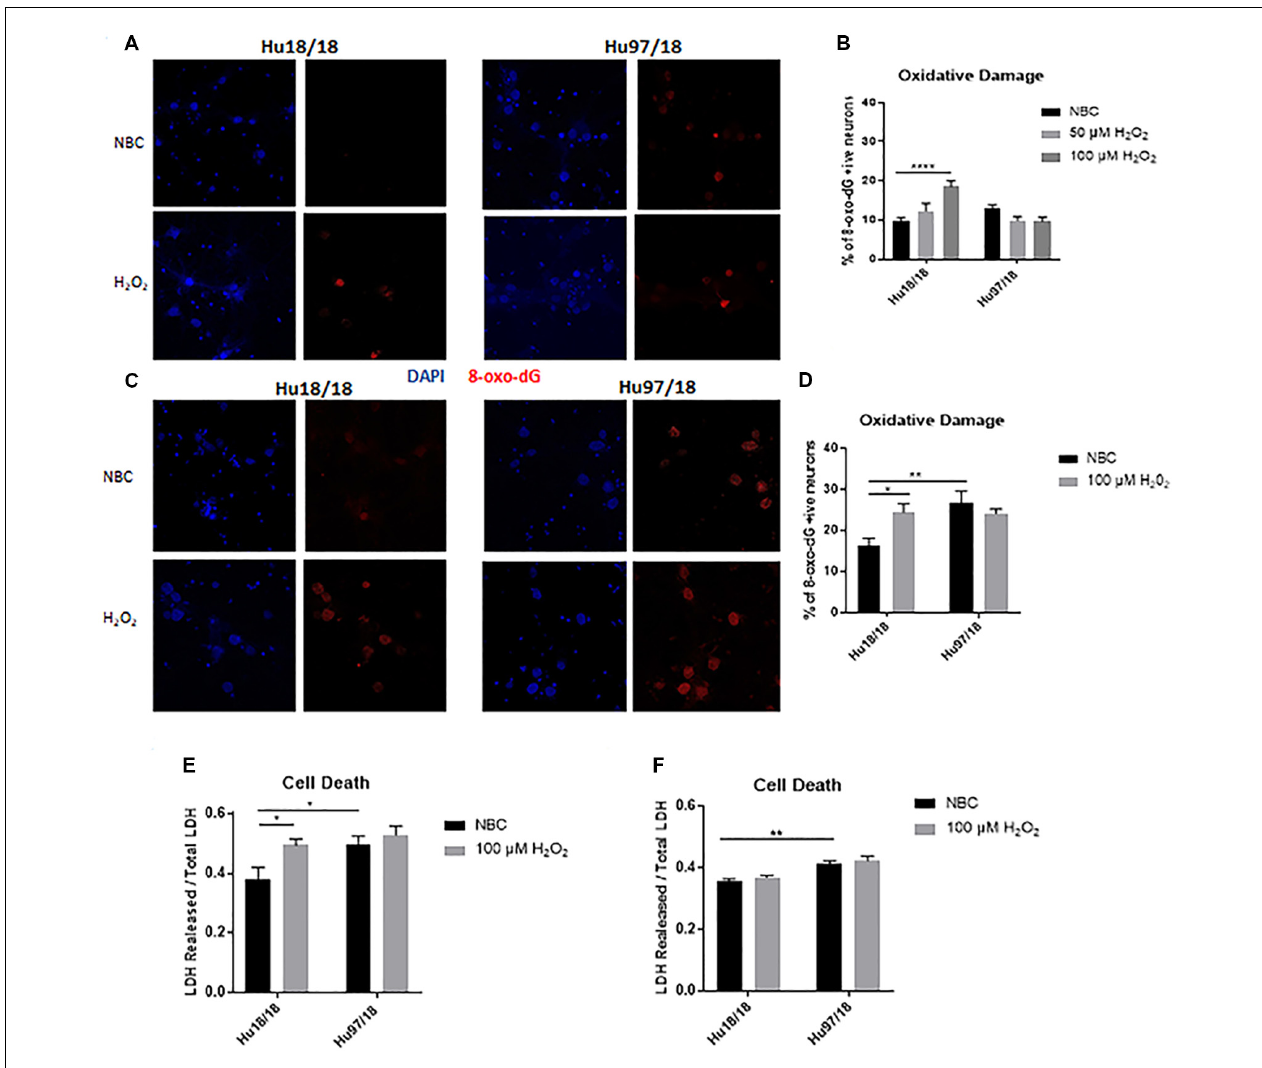
FIGURE 2 | Oxidative stress does not induce oxidative damage or cell death in HD primary neurons. Primary Hu18/18 and Hu97/18 neurons were treated with NBC vehicle or 100 µ M H 2 O 2 for 24 h. (A–D) DNA damage was assessed by 8-Oxo-dG immunocytochemistry. (A,B) Representative images (A) and quantification (B) of % 8-Oxo-dG positive immature neurons. (C,D) Representative images (C) and quantification (D) of % 8-Oxo-dG positive mature neurons. (E,F) Cell death was assessed byquantifyingLDHreleased/totalin (E) immatureand (F) matureneurons.*Differencebetweenindicatedbars,* p < 0.05,** p < 0.01,**** p < 0.0001.Errorbars ± SEM.